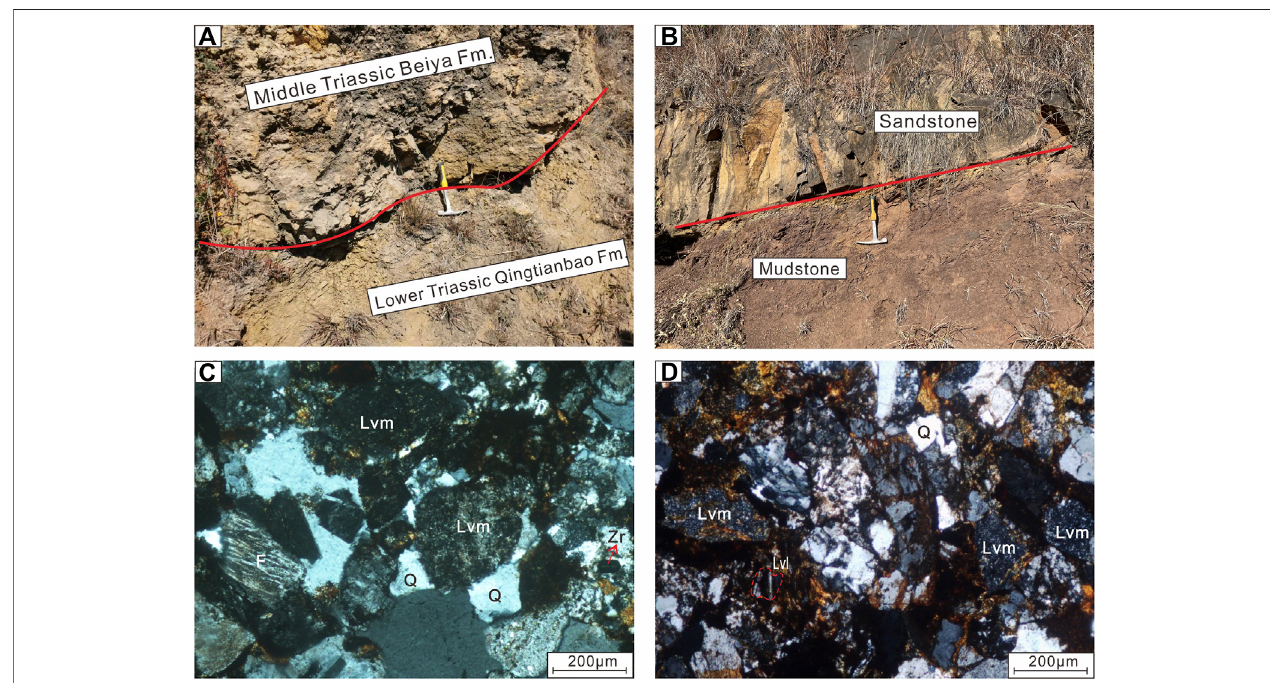
FIGURE 4 | Representative fi eld outcrops and photomicrographs of clastic rocks at Dengchuan. (A) Boundary between the Middle Triassic Beiya Formation and Lower Triassic Qingtianbao Formation. (B) Sandstone and purple mudstone in the middle part of the Qingtianbao Formation. (C) Sandstone sample Ts-10. (D) Sandstone sample Ts-19. The photomicrographs of samples are in cross-polarized light. Volcanic rock fragments of lathwork (Lvl) and microlitic (Lvm); quartz (Q); feldspar (F); and zircon (Zr).